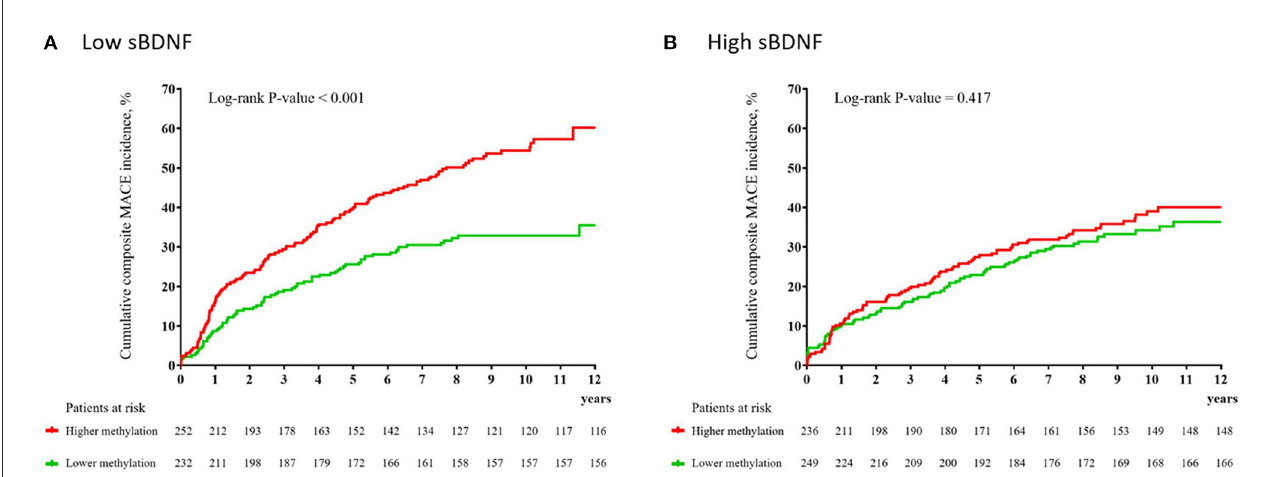
FIGURE1 Cumulative incidence (%) of composite major adverse cardiac events (MACEs) according to the average BDNF methylation level at baseline in patients with low (A) and high (B) serum brain-derived neurotrophic factor (sBDNF)